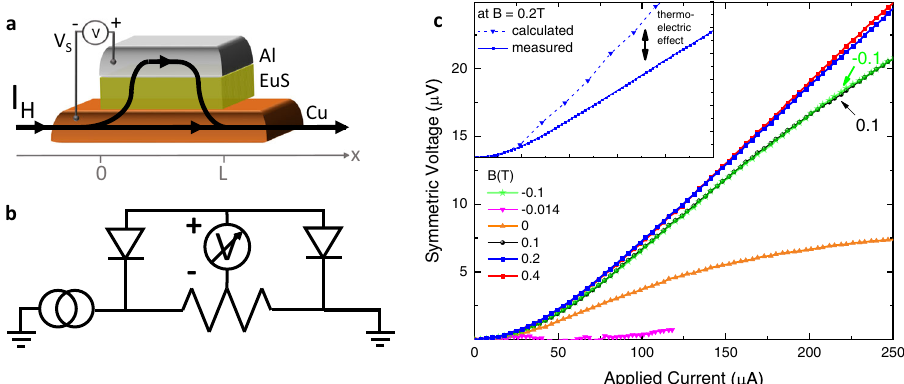
Fig. 3 Transverse recti fi cation of the superconducting tunnel diode. a Schematic of the N/FI/S tunnel junction and current path. A biasing current I H is applied from one end of the Cu strip to the other, while the voltage drop across the junction is measured from the Al contact to the Cu one. The path of tunneling current is indicated by the black line and its arrows. b Electronic circuit diagram of the setup. Note that the EuS layer effectively acts as a twofold recti fi er for the distributed incoming and outgoing currents tunneling through the FI barrier. c Transverse voltage drop V sym ( I Cu ) measured across the barrier as a function of the applied current I H at different B and at 50 mK. Note that even at zero applied magnetic fi eld (orange curve) a voltage drop occurs, while at the coercive fi eld ( B ≃ − 14 mT) the signal is zero due to the non-polarization of the EuS layer. The V ( I ) was symmetrized in order to discard the Ohmic (linear) component originating from the N lead. In the inset, the V sym measured at 0.2 T is compared with the calculated data points obtained through a theoretical model of the circuit and using the recti fi cation value obtained from the experimental